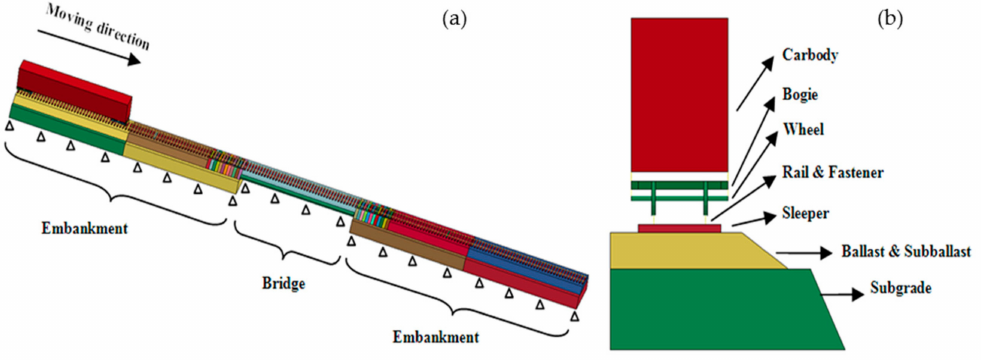
Figure 11. Finite Element (FE) model of the track transition zone: ( a ) full view; ( b ) cross-section of ballast